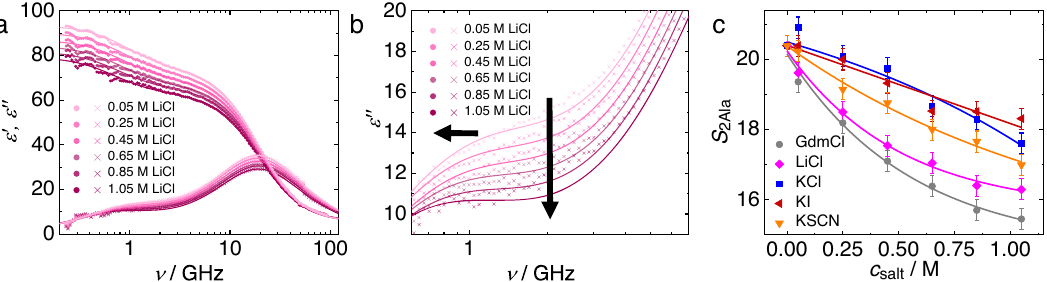
Fig. 3 Decrease in 2Ala ’ s relaxation amplitude is salt-speci fi c. a Complex permittivity spectra of aqueous 2Ala solutions (0.25 M) with increasing concentration of LiCl. b Zoom into lower-frequency loss spectra, which are dominated by the 2Ala relaxation, with arrows indicating the trend with increasing concentration. Solid circles and crosses show the experimental dielectric permittivity ( ε ′ ) and dielectric loss spectra ( ε ″ ), respectively. Solid lines show fi ts of Eq. (1) to the experimental data. Note that the conductivity contribution (last term of Eq. (1)) has been subtracted for visual clarity. c 2Ala relaxation strength, S 2Ala , (Eq. (1)) as a function of c salt for different salts. Error bars correspond to twice the standard deviation from the parameters obtained from eight independent experiments. Lines are guides to the eye.